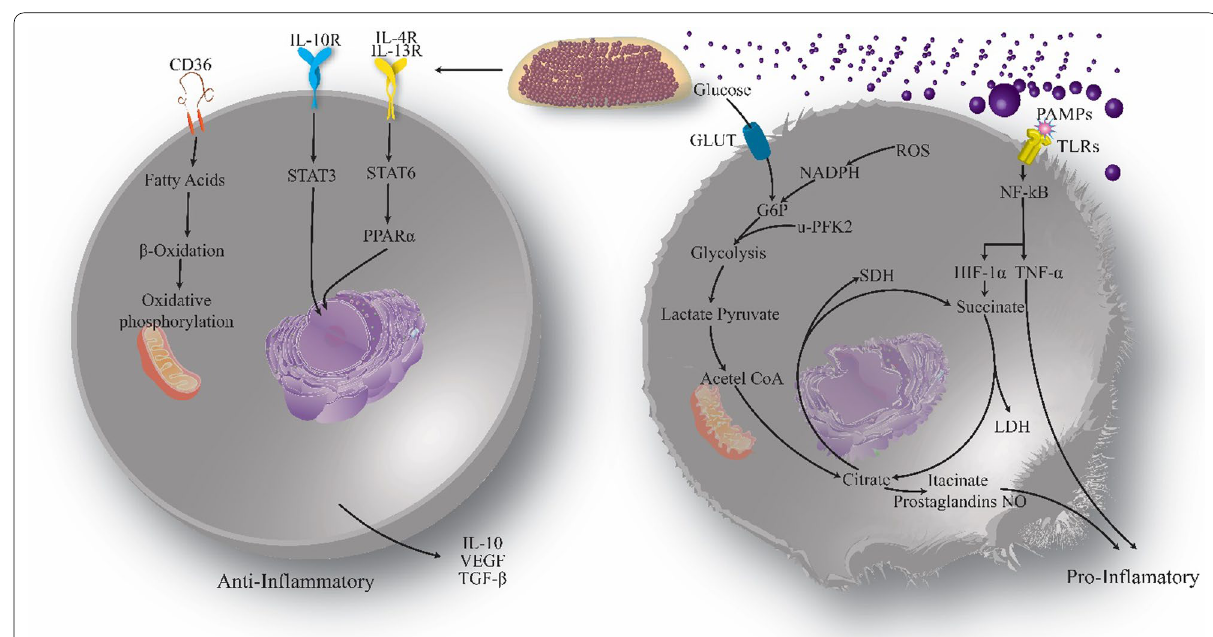
Fig. 7 Macrophages and their metabolic changes can change their inflammatory status to a biofilm infection. In planktonic infections, macrophages encounter pathogen-associated molecular patterns (PAMPs) that favor aerobic glycolysis to provide tricarboxylic acid (TCA) cycle intermediates required for proinflammatory effector mechanisms. In contrast, macrophages are polarized towards an anti-inflammatory state in biofilm infections. Although most of the factors involved in this process are unknown, it is predicted that biofilm infections will bias macrophages towards OXPHOS and several receptors such as IL-4R, IL-13R, IL-10R, and CD36 which are associated with anti-inflammatory cytokines (e.g., IL-10 and TGF-β) might be involved. The metabolic gradients of nutrients and oxygen present in the tissue microenvironment also influence macrophages’ anti- versus pro-inflammatory states (Yamada and Kielian 2019). G6P, glucose-6-phosphate; IDH, isocitrate dehydrogenase; iNOS, inducible nitric oxide synthase; PPP, pentose phosphate pathway; SDH, succinate